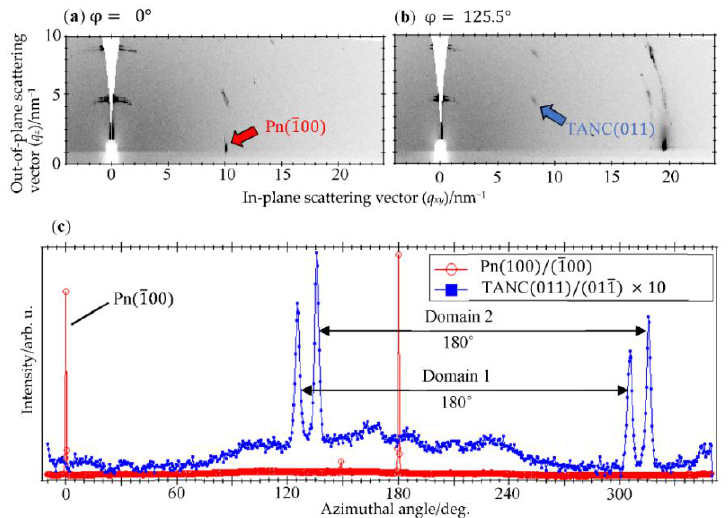
Figure 2. ( a ) 2D-GIXD image of the TANC(20 nm)/PnSC taken at φ = 0° . ( b ) 2D-GIXD image of the same sample as in ( a ) taken at φ = 125.5° . ( c ) Diffraction intensities of the PnSC (100)/(1 ̅ 00) and TANC (011)/(011̅) spots plotted as a function of φ . The vertical scale is normalized for the maximal intensity of each curve.